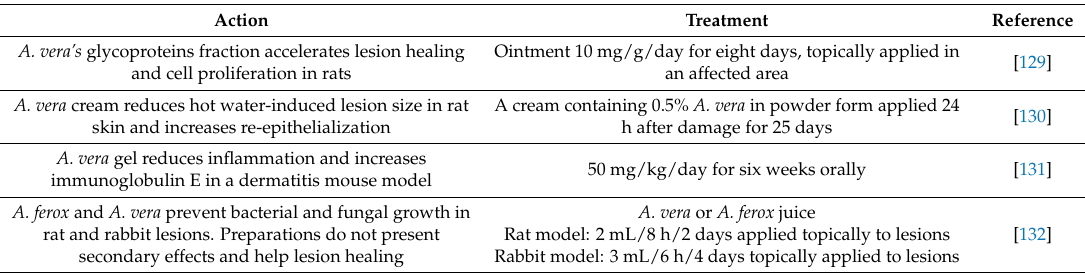
Table 2. Actions of Aloe vera